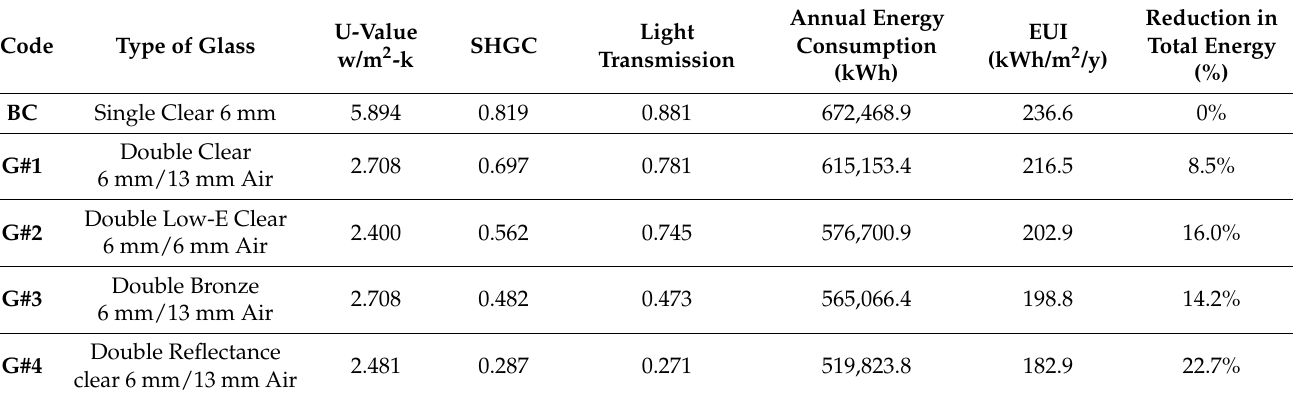
Table 4. Alternative window